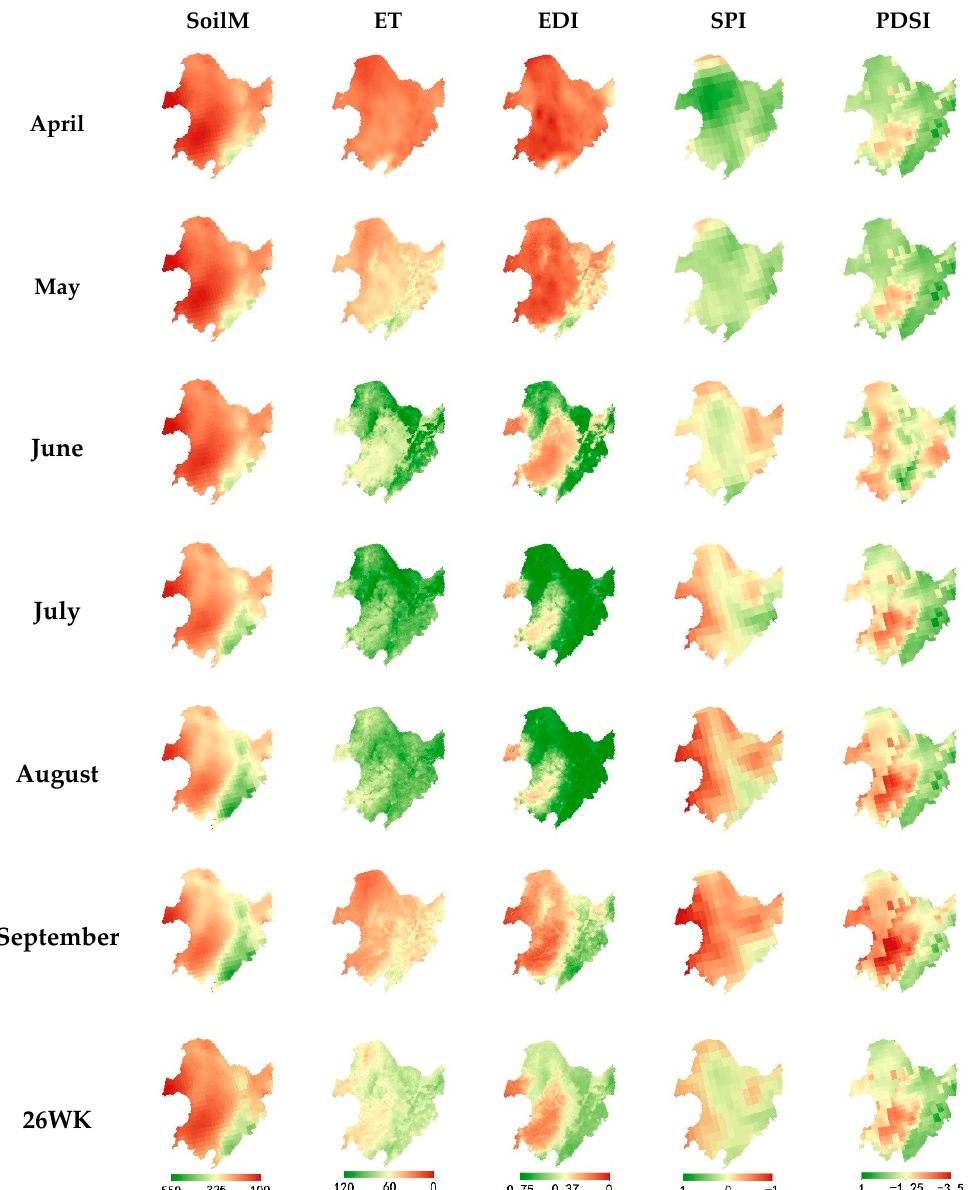
Figure 3. Monthly and seasonally composited (26-week) maps of normal conditions for the Soil Moisture (SoilM) (mm), evapotranspiration (ET) (mm / month), Evaporative Drought Index (EDI) (-), Standardized Precipitation Index (SPI) (-), and Palmer Drought Severity Index (PDSI) (-). Green indicates wetter conditions and red indicates drier conditions.